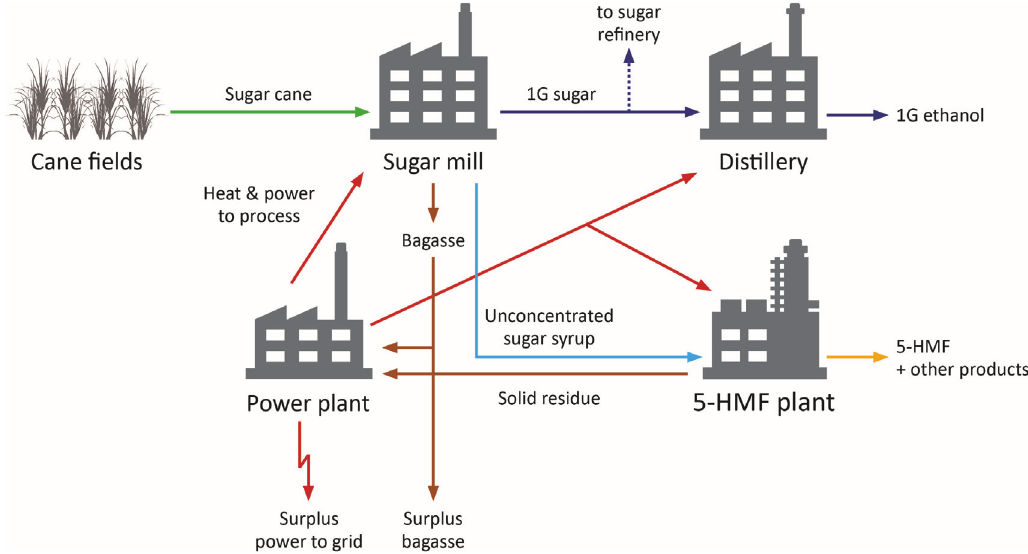
Figure 2 Production route for bio-based